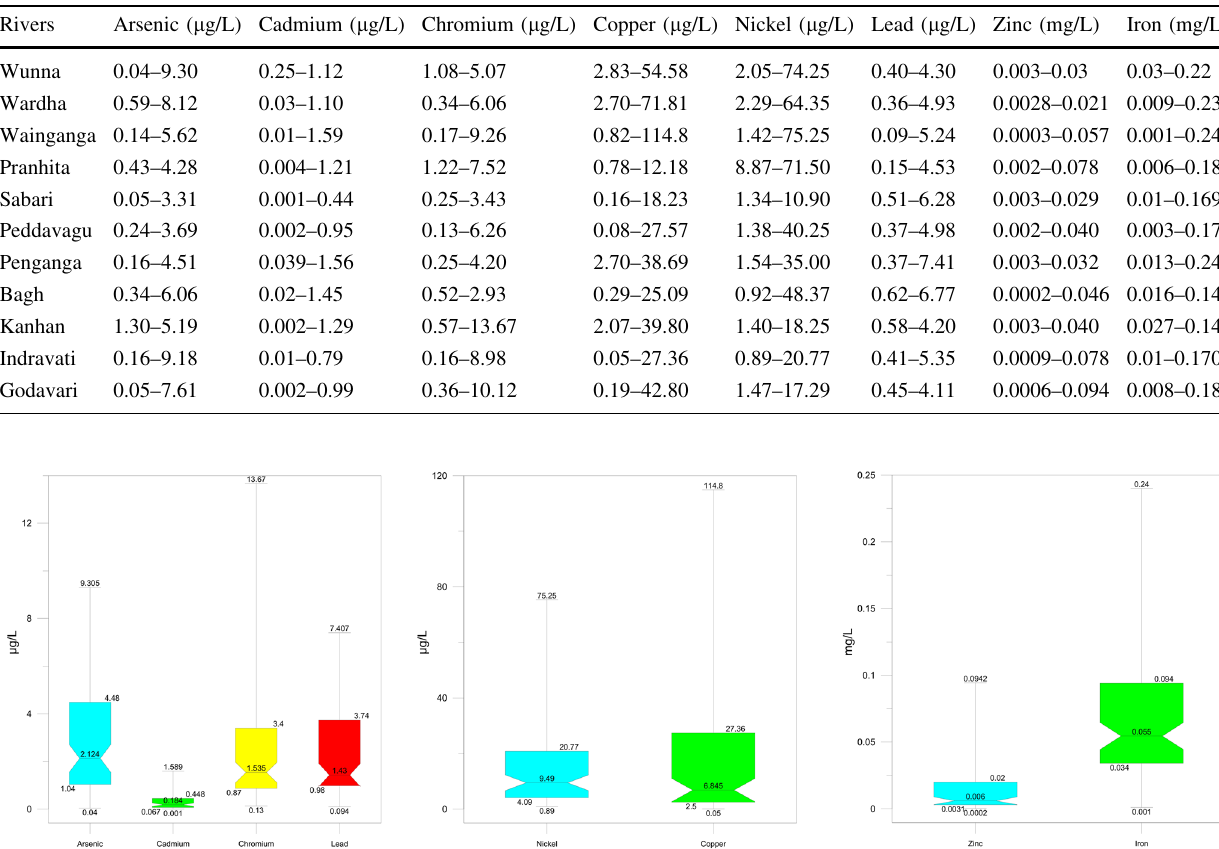
Fig. 2 Box Whisker diagram (Sept. 2011 to Aug.